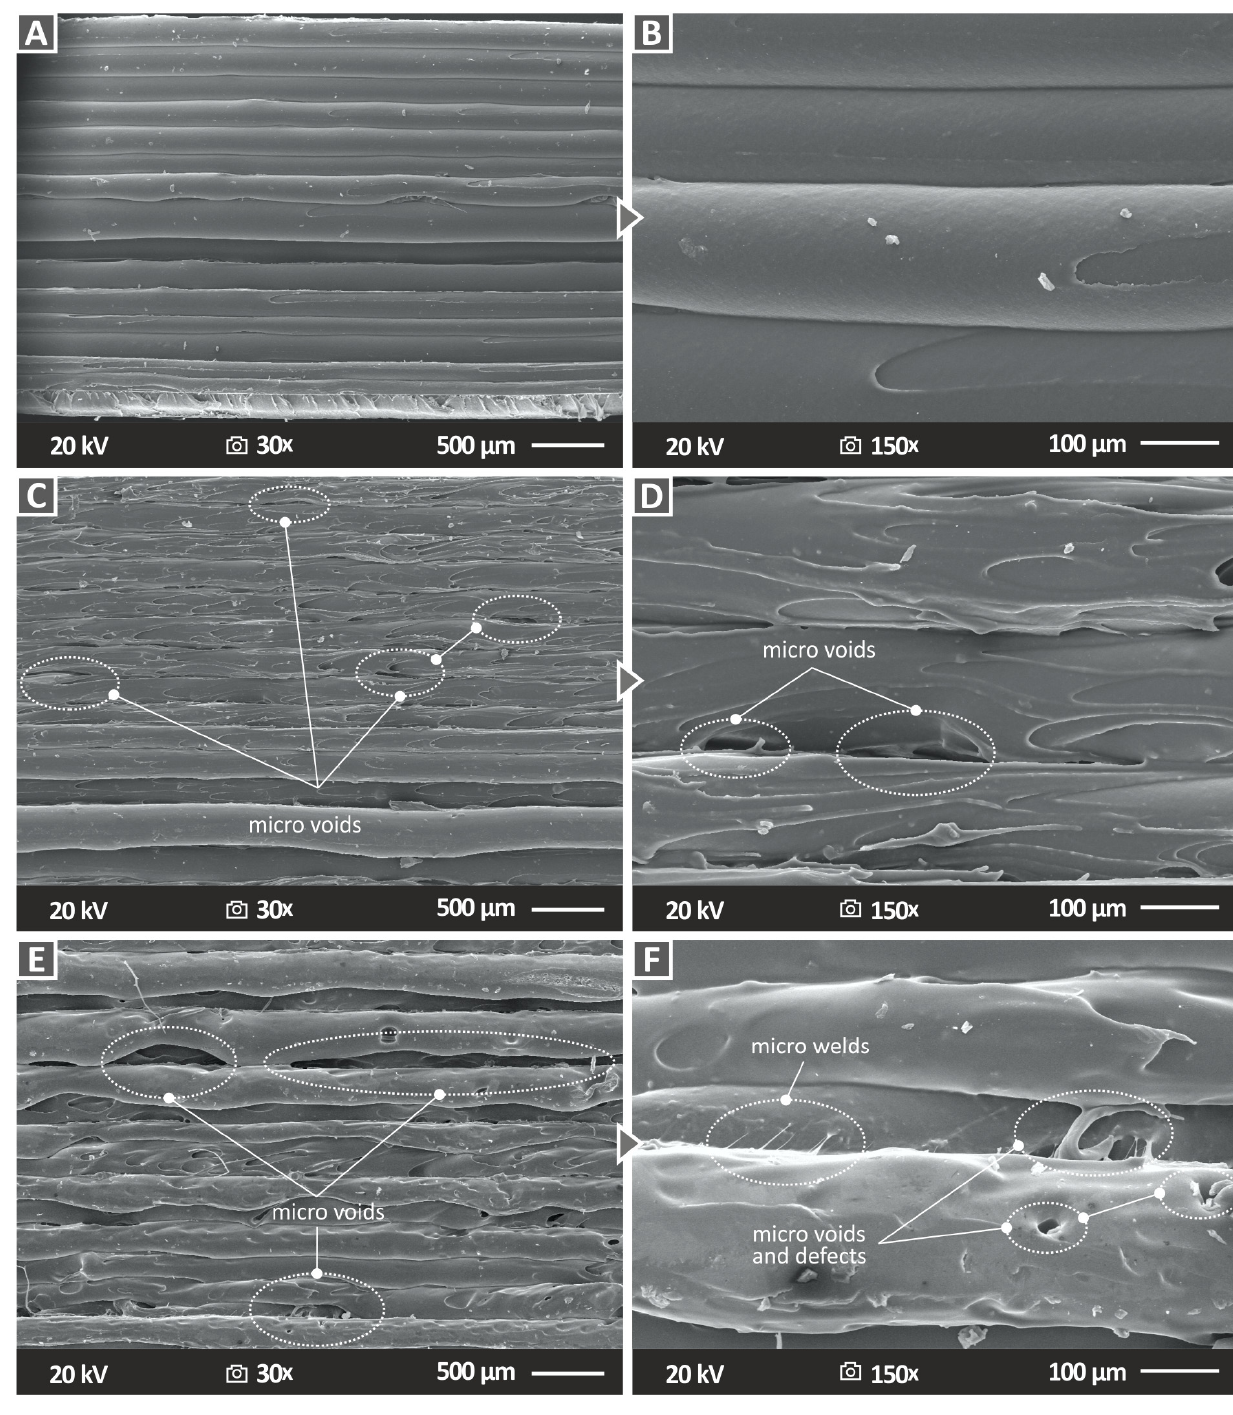
Figure 12. Side surface SEM images for ( A ) pure ABS at 30× magnification, ( B ) pure ABS at 150× magnification ( C ) ABS/TIN 4 wt. % at 30× magnification ( D ) ABS/TIN 4 wt. % at 150× magnification ( E ) ABS/TIN 8 wt. % at 30× magnification ( F ) ABS/TIN 8 wt. % at 150× magnification. Figure 13 illustrates the corresponding fracture surface images of the investigated samples at two different magnification levels. For the pure ABS polymer, no defects or